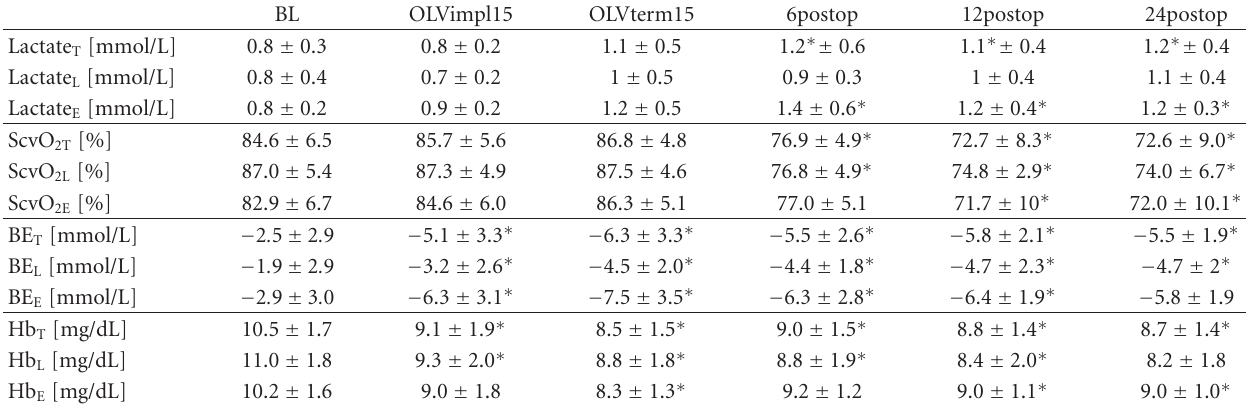
Table 3: Metabolic data. ScvO 2 : central venous oxygen saturation; BE: base excess. ∗ Di ff erence to BL in analysis of variance (ANOVA) ( P < 0 . 05). BL: directly after induction of anesthesia; OLVimpl15: 15 minutes after beginning OLV; OLVterm15: 15 minutes after cessation of OLV; 6postop: 6 hours after surgery; 12postop: 12 hours after surgery; 24postop: 24 hours after surgery. BL OLVimpl15 OLVterm15 6postop 12postop 24postop Lactate T [mmol/L] 0.8 ± 0.3 0.8 ± 0.2 Lactate L [mmol/L] 0.8 ±